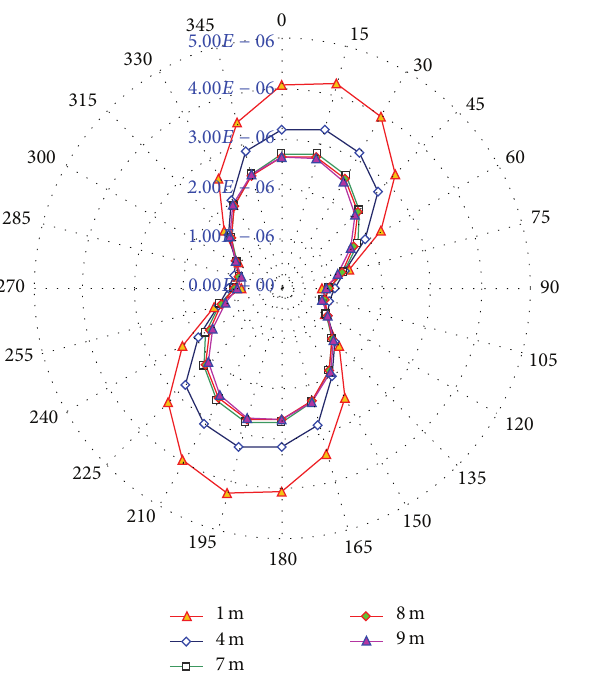
Figure 14: Damage tensor ( × 10 −1 ).